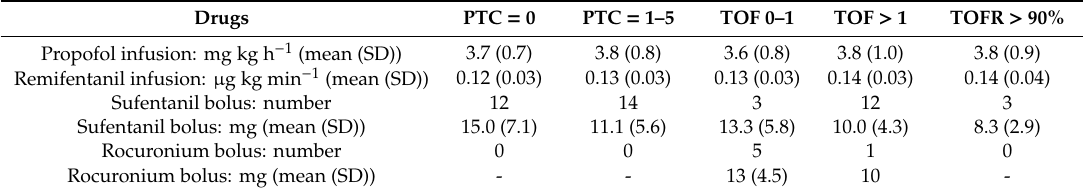
Table 2. Administration of propofol, analgesics, and rocuronium.